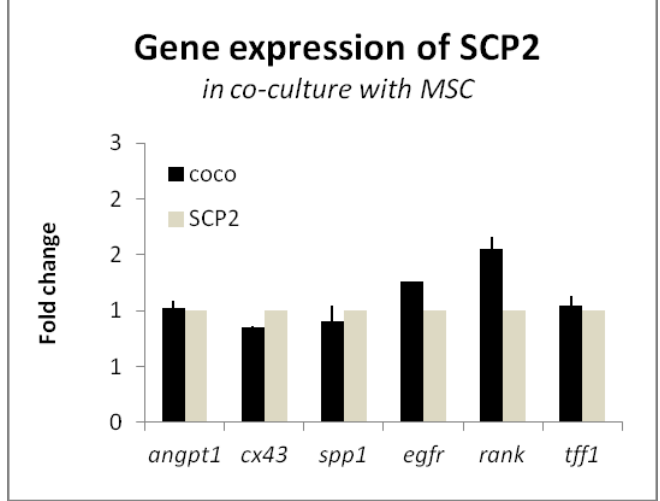
Figure 2. Co-culture with MSC upregulates EGFR and RANK expression in SCP2. Expression of angpt1 , cx43 , spp1 , egfr , rank and tff1 in SCP2 cells co-cultured with MSC. Fold change compared to SCP2 monoculture at baseline.